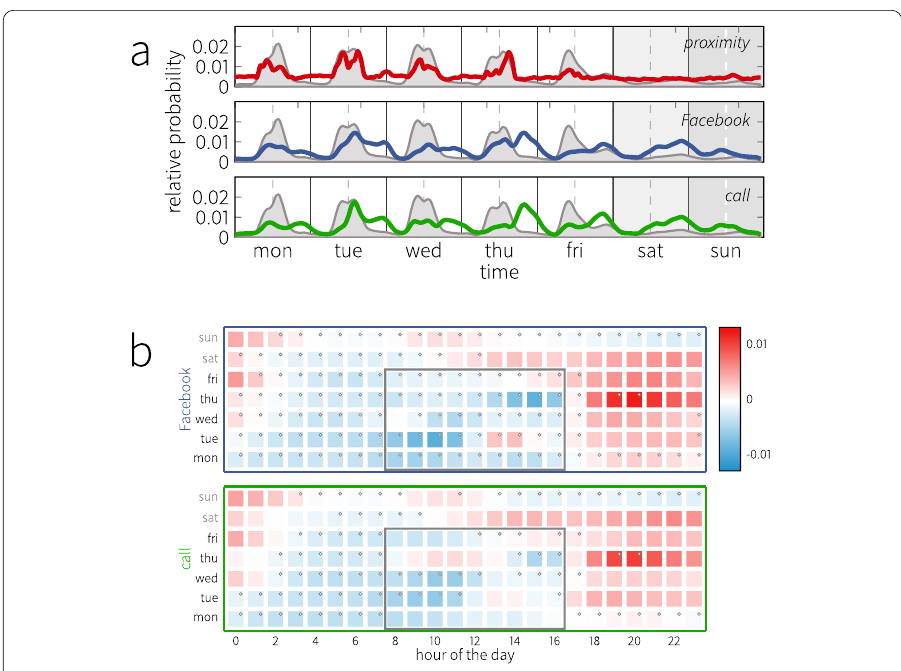
Figure 7 Physical activity of central individuals when closeness centrality is used in the communication networks. (a) Relative probability of physical contacts, compared to the distribution of the population average (grey area). Dark regions indicate weekends. (b) Heat maps showing the difference in the contact activity between the social core and the proximity driven for each hour in a week. The periods for working hours are surrounded by the grey frame. In all cases, the 10 most central individuals are considered, and results are aggregated over a four month period between February and May 2014 (inclusive). Hours of significant difference are marked by the white